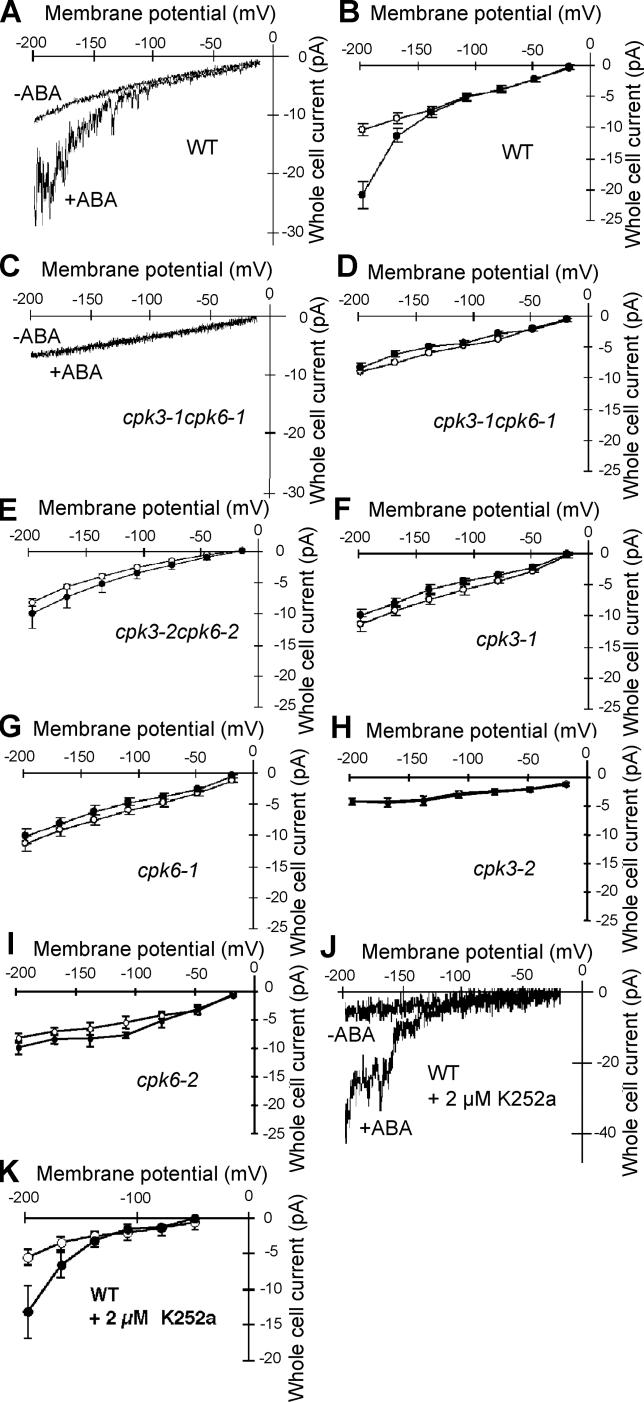
Impairment in ABA Activation of ICa Channel Currents in cpk3 and cpk6 Single Mutants and cpk3cpk6 Double Mutants(A and B) ABA (50 μM) activated ICa channel current in wild-type (WT) guard cells. (A) Current traces before (−ABA) and after ABA (+ABA) activation of ICa channels are shown in a representative cell. (B) Average current-voltage curves (n = 13) are shown.(C and D) ABA failed to activate ICa channel currents in cpk3-1cpk6–1 double mutant guard cells. (C) A response in a representative cell is shown. (D) Average current-voltage curves (n = 14) are shown. Traces before and after ABA overlap in (C).(E–I) Averages of current-voltage curves in guard cells isolated from (E) cpk3-2cpk6–2 double mutant (n = 8), (F) cpk3–1 (n = 11), (G) cpk6–1 (n = 9), (H) cpk3–2 (n = 3), and (I) cpk6–2 (n = 5) are shown.(J and K) ABA activation of ICa channel currents in wild-type (WT) guard cells pretreated with the protein kinase inhibitor K252a (2 μM) for 15 min prior to and during patch clamping and with no ATP added in the patch pipette solution. Response in a guard cell is shown in (J), and average current-voltage curves (n = 6) are shown in (K).Open symbols indicate −ABA and closed symbols indicate +ABA. Error bars represent SEM.